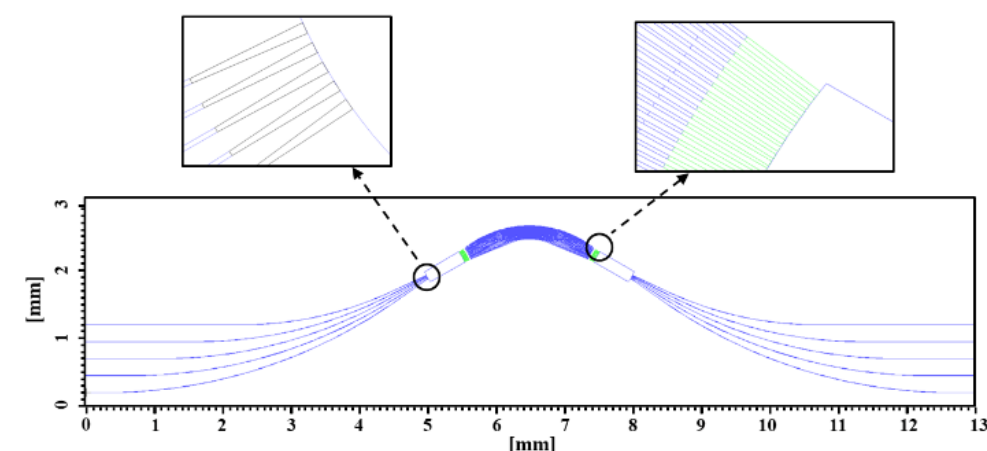
Figure 2. Layout schematic of the fabricated AWG device.